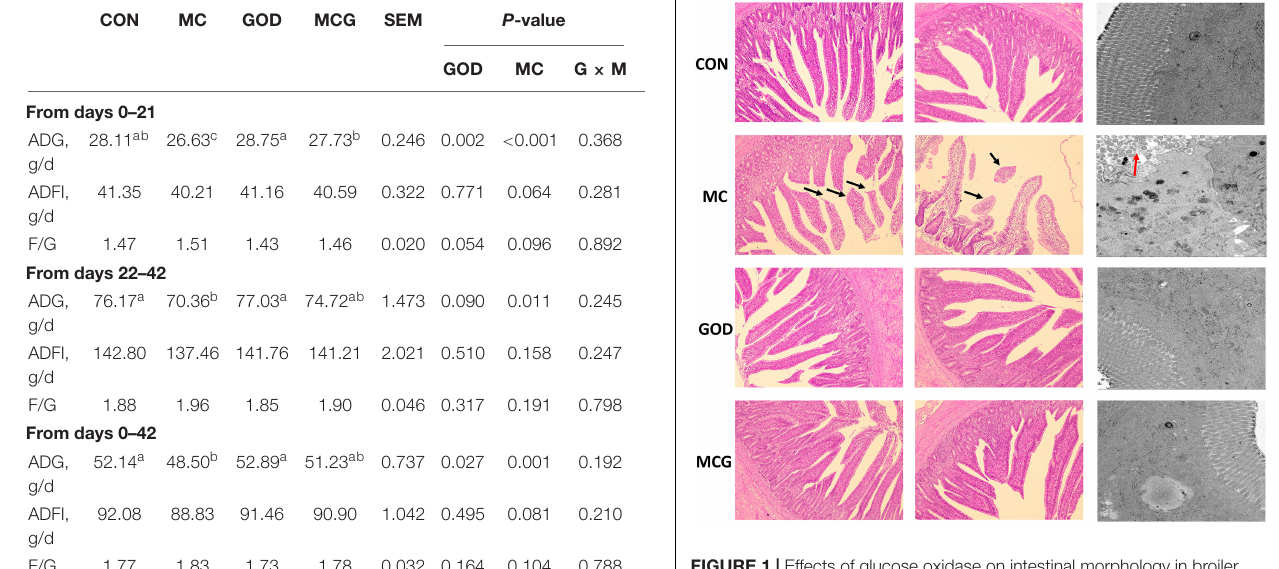
FIGURE 1 | Effects of glucose oxidase on intestinal morphology in broiler chickens fed mold contaminated corn. Results of jejunum (left) and ileum morphology (middle) by HE staining (magnification × 100). Results of ileum morphology (right) by transmission electron microscope (magnification × 5,000). Black arrows, partial loss of villi; red arrows, irregularly arranged